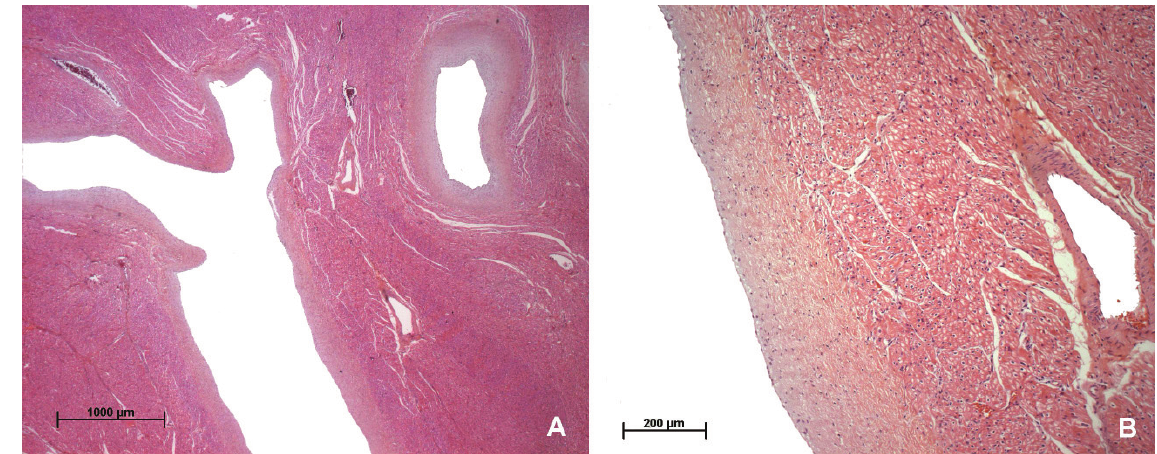
Figure 2 - Photomicrographs of the left ventricular myocardium showing in A) the deep myocardial recesses and in B) the thickened endocardium. Hematoxylin-eosin satin, objectives A) 2.5X and B)